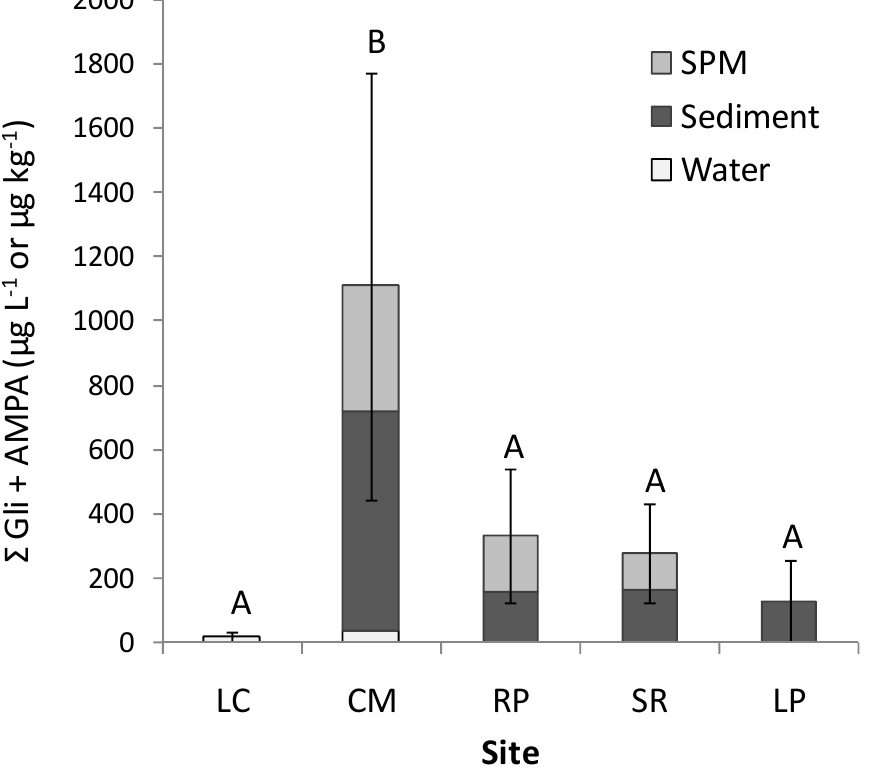
Figure 3. Addition of glyphosate and aminomethylphosphonic acid (AMPA) quantified in water (µg L − 1 ), sediment (µg kg − 1 ) and suspended particulate matter (SPM µg kg − 1 ) samples from the Suquía River basin. Different letters indicate significant differences between monitoring sites ( p < 0.05). LC: La Calera, CM: Villa Corazón de María, RP: Río Primero, SR: Santa Rosa de Río Primero, LP: La Para.